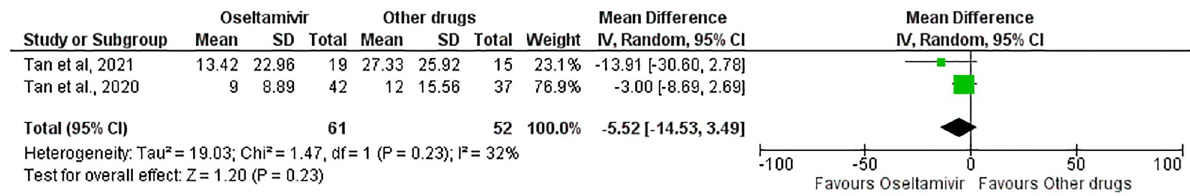
Fig 11. Forest plot. Shows the effect estimate of duration of hospitalisation of oseltamivir monotherapy vs Corticosteroid monotherapy.